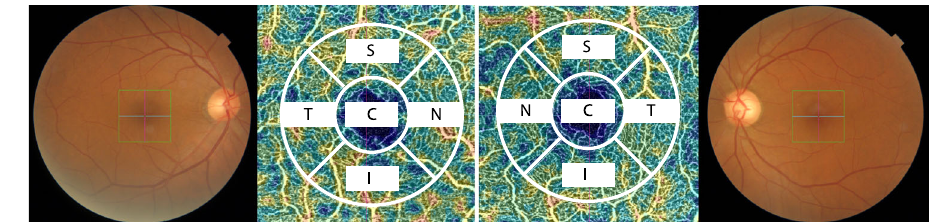
Fig. 3 Representative fundus photography and OCTA images of the macular area in a healthy control. Macular OCTA measurement was obtained by automatically applying an Early Treatment Diabetic Retinopathy Study (ETDRS) grid overlay containing the two inner rings of the ETDRS grid pattern to the fovea, which yielded the vessel density in each layer. C center, T temporal quadrant, I inferior quadrant, N nasal quadrant, S superior